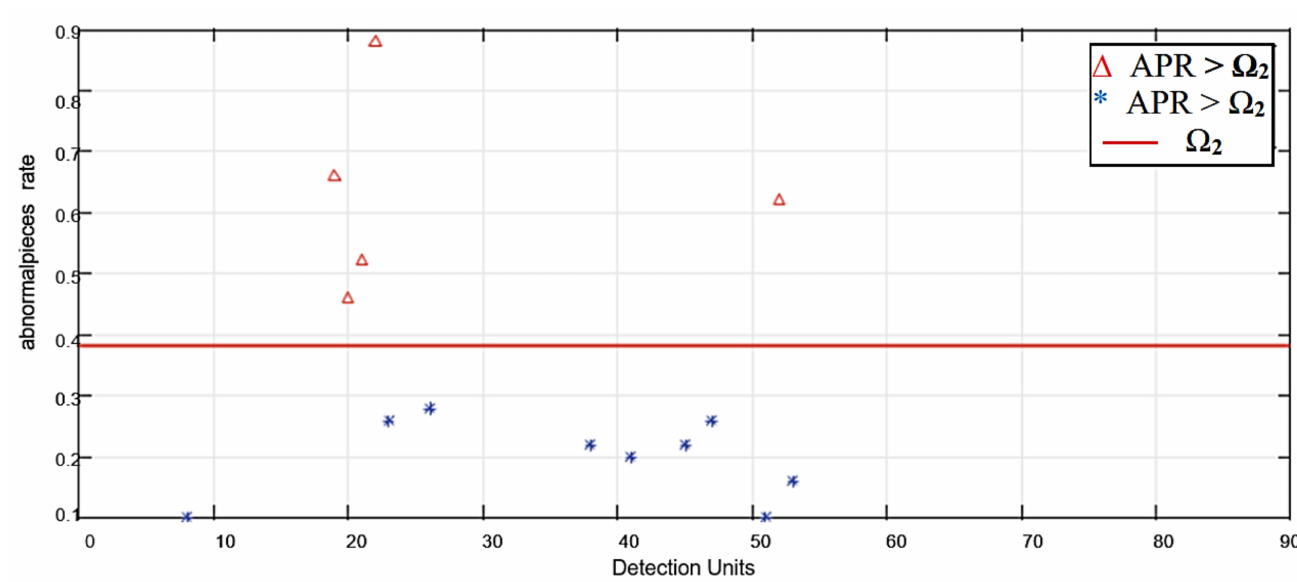
Figure 10. Result based on abnormal piece